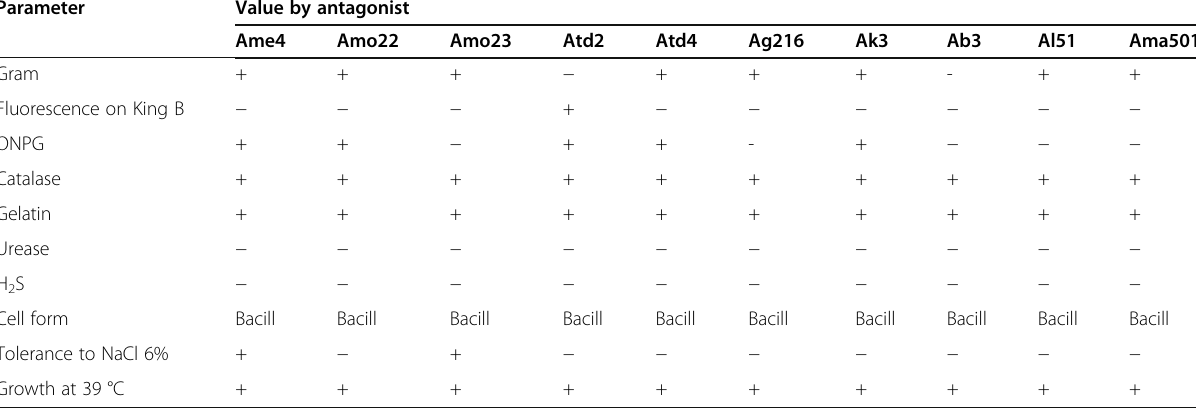
Table 2 Phenotypic, physiological, and biochemical characterization of the antagonists